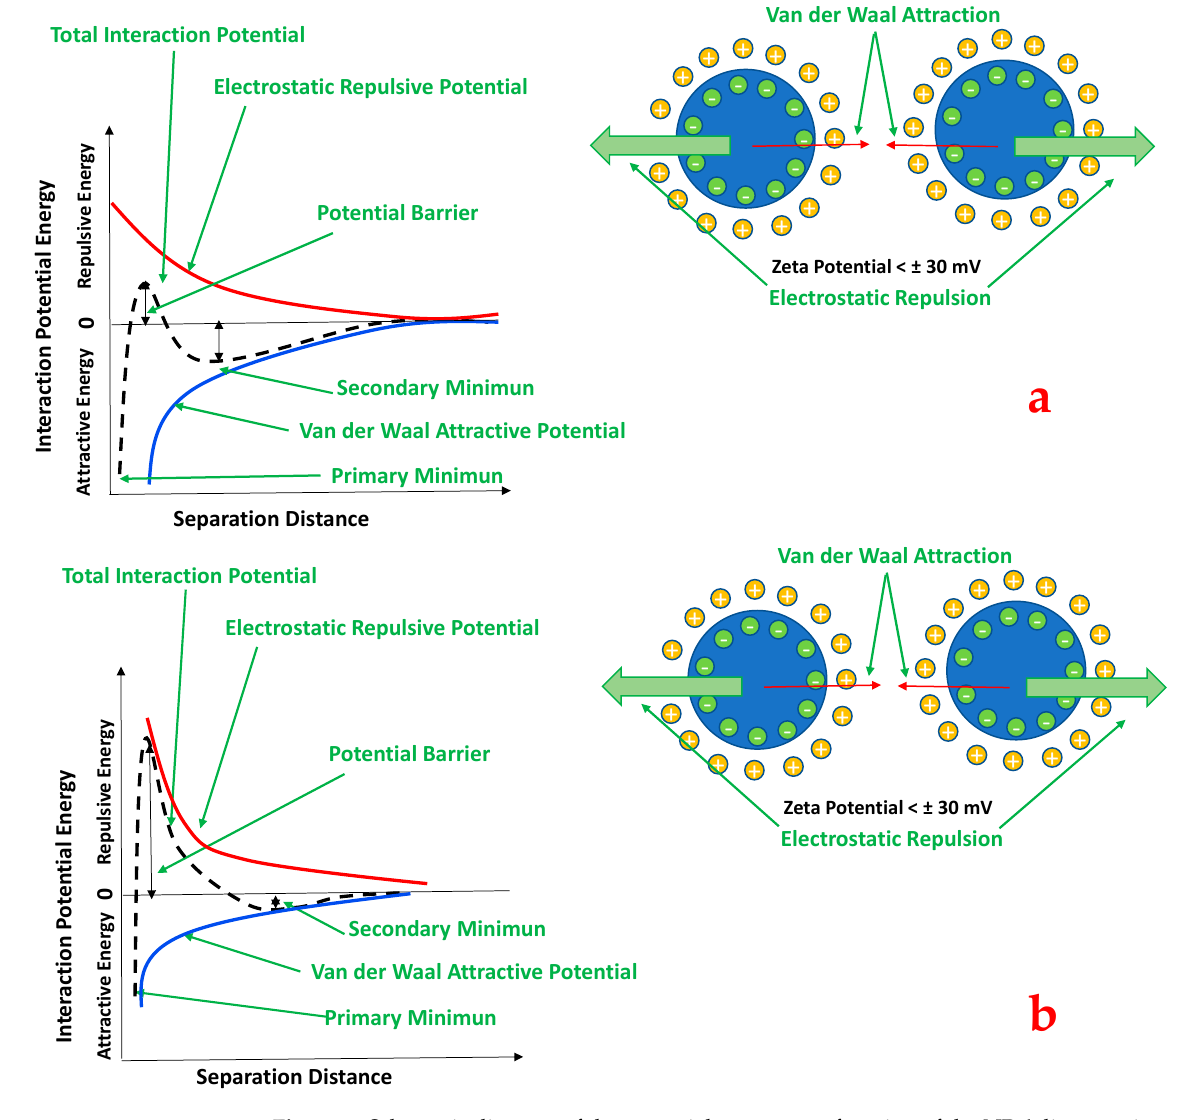
Figure 3. Schematic diagram of the potential energy as a function of the NPs’ distances in two cases: ( a ) low potential barrier, and ( b ) high potential barrier.